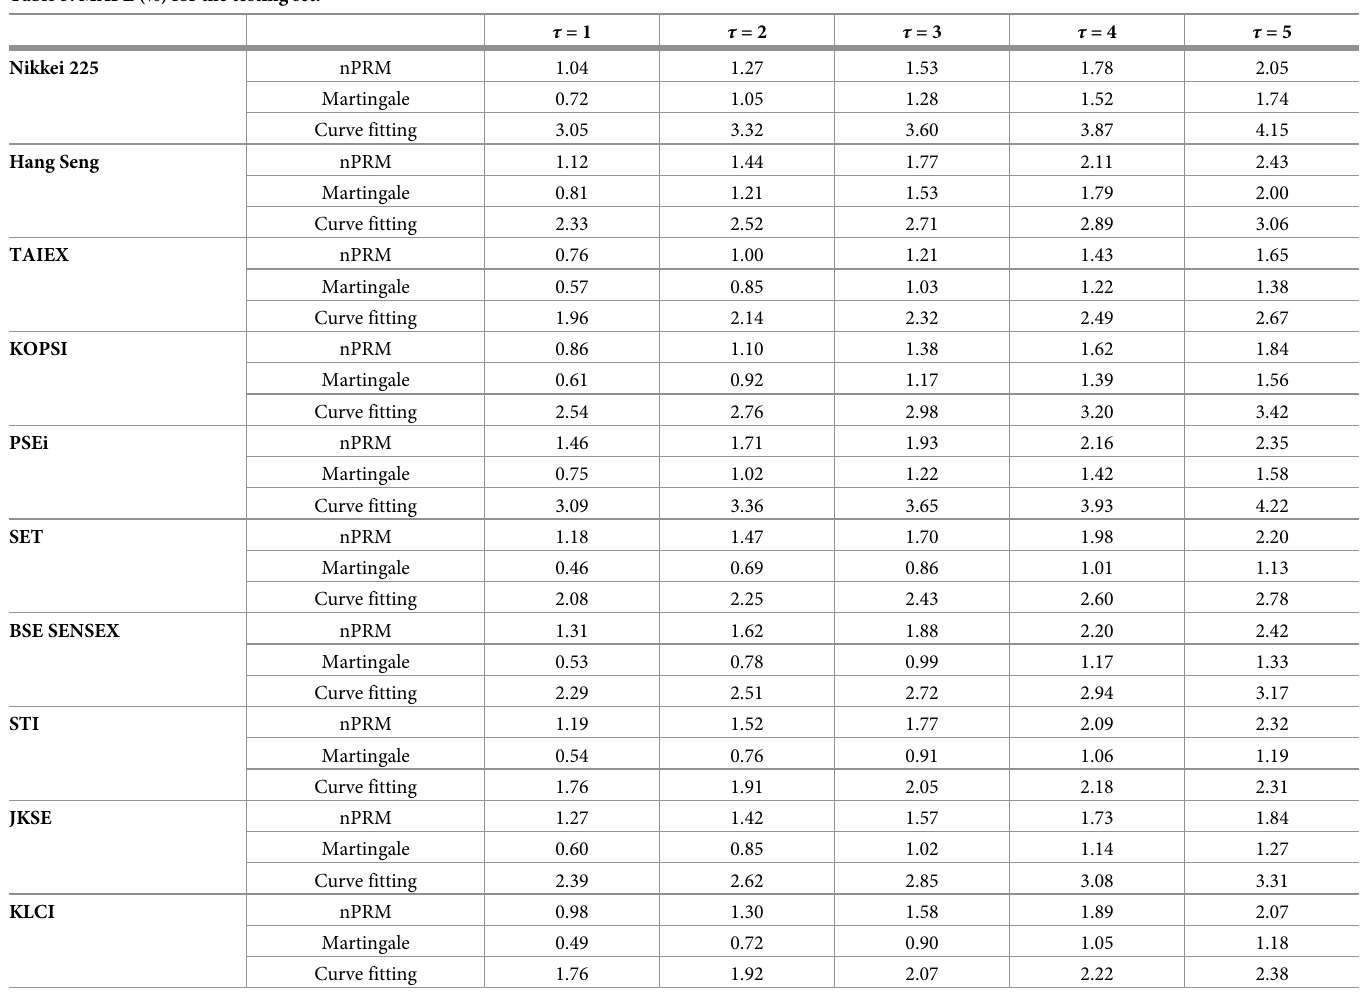
Table 3. MAPE (%) for the testing